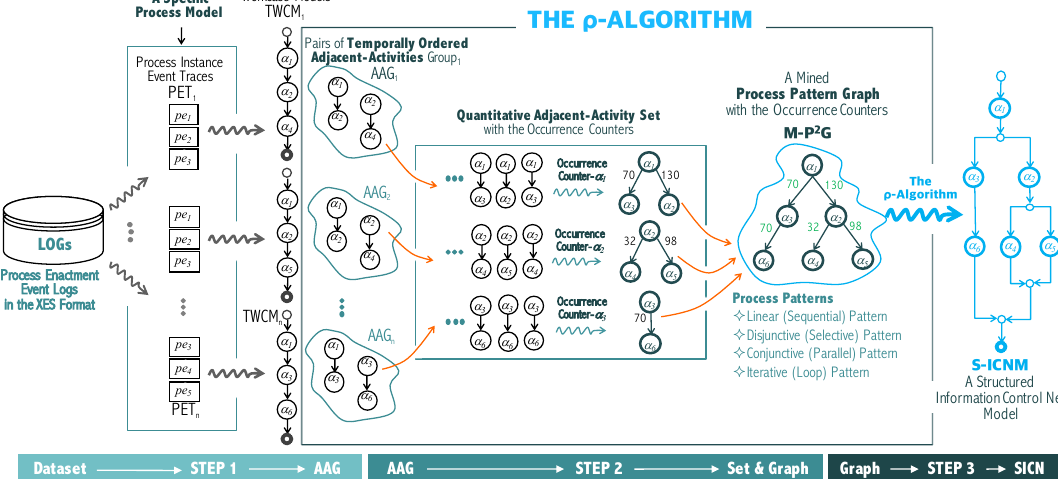
Figure 5. The ρ -Algorithm with three steps of graphical